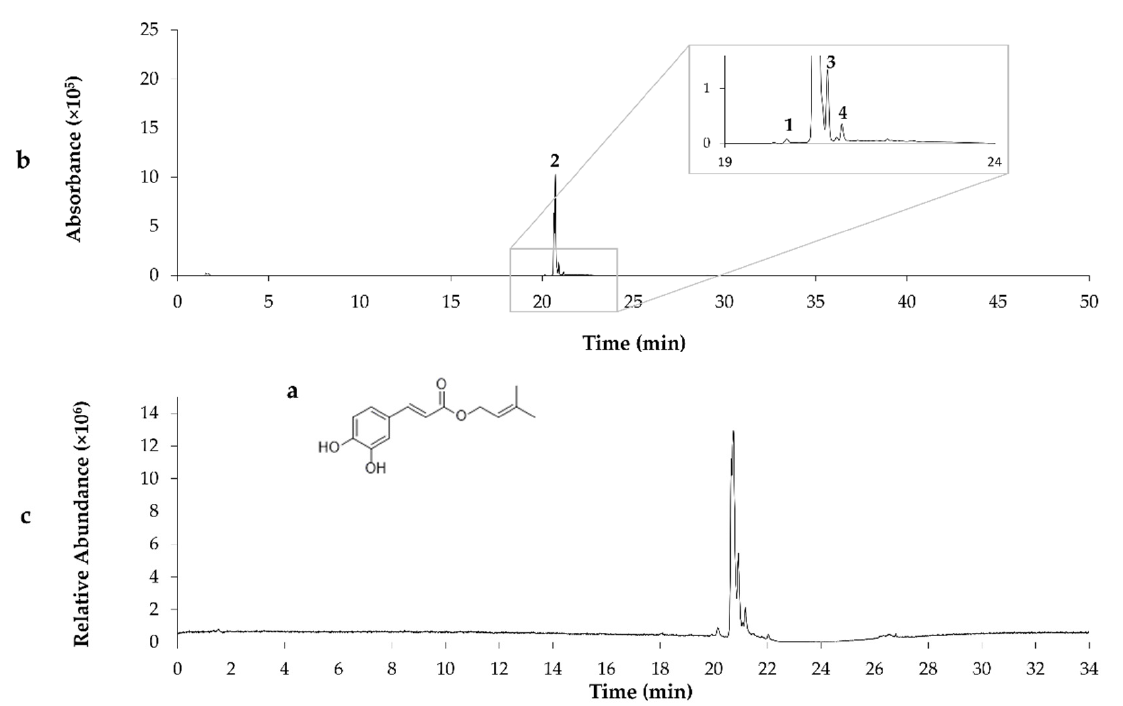
Figure 4. The chemical structure of caffeic acid isoprenyl ester ( a ); LC-MC chromatogram of P3 isolated from G18.EE-EtOAc fraction using ESI ( b ); TIC chromatogram in negative ion mode ( c ); Quercetin-dimethyl ether ( 1 ); Caffeic acid isoprenyl ester ( 2 ); Caffeic acid phenylethyl ester ( 3 ); Caffeic acid cinnamyl ester ( 4 ).